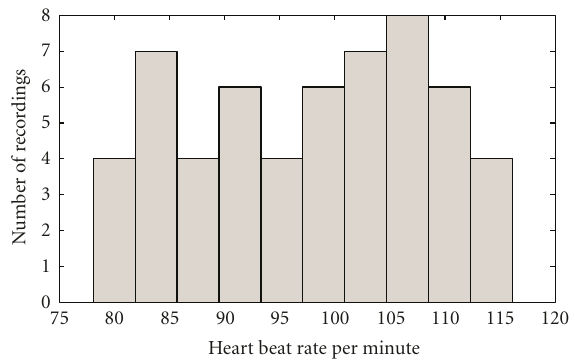
Figure 2: Histogram of heart beat rate per minute for a given set of labeled PPG fragments.